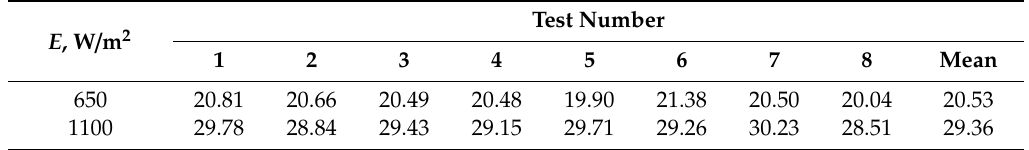
Table 4. Air temperature changes, t in − t amb (K), between the solar collector inlet and outlet. E , W/m 2